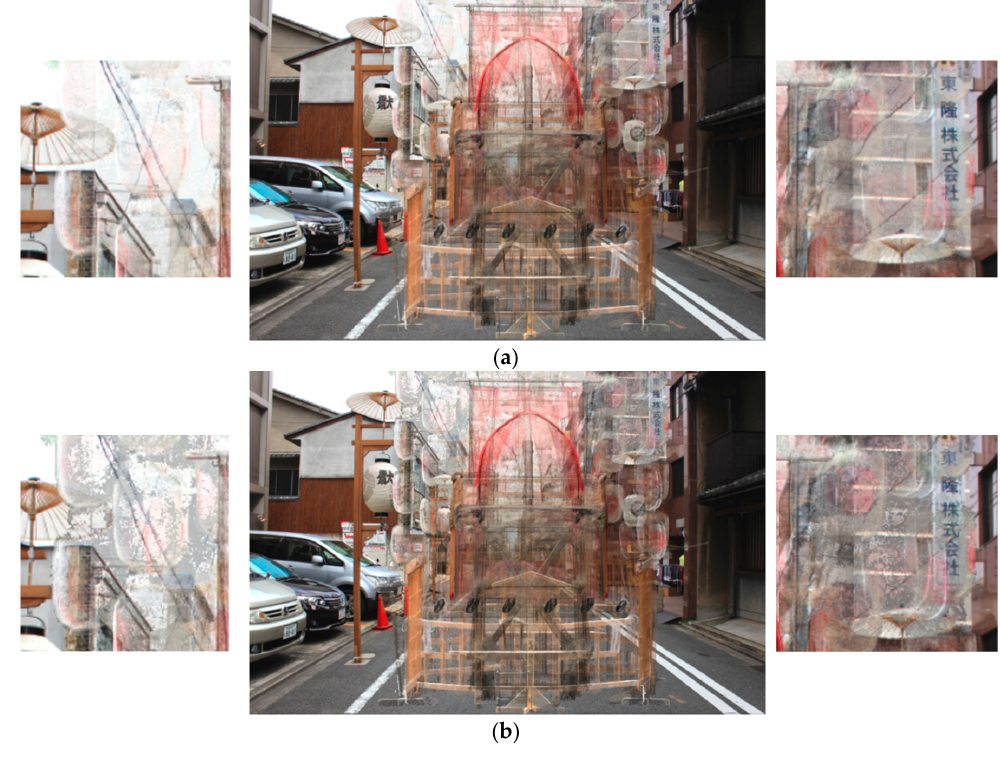
Figure 4. Visualization of ( a ) the color difference between the point cloud and the background and ( b ) number of projected